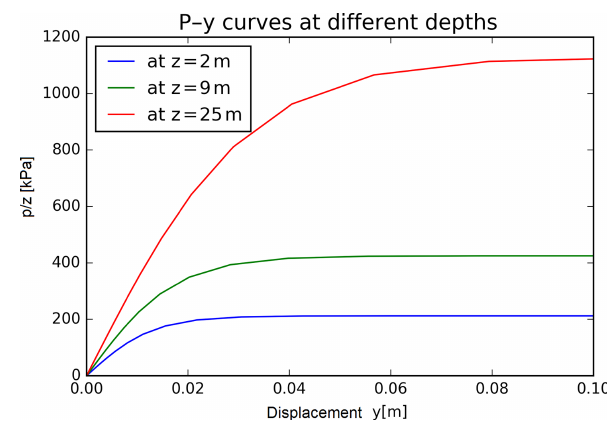
Figure 12. Examples of p – y curves from the different soil